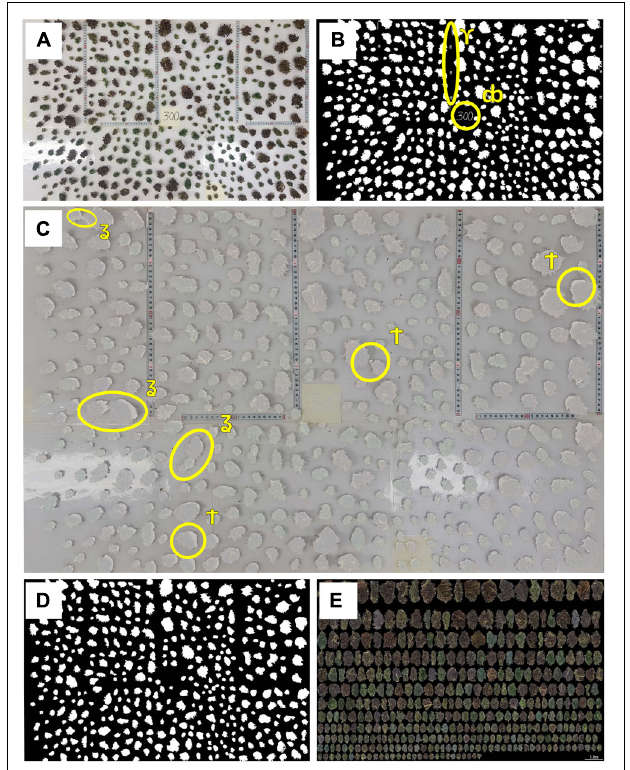
FIGURE 2 | Preparation procedure for inflorescence image analysis. (A) An example of the total processed inflorescences distributed over a scaled surface which formed the raw image for morphological analysis, (B) Binary (black and white) image of the distributed inflorescences, (C) Raw and binary images juxtaposed onto one figure to highlight any requirements for manual editing, (D) Processed (cleaned) binary image with only inflorescence material included, (E) Composite image containing all inflorescences within the examined plant which are ordered by size. The following symbols indicate areas of concerns in the raw data: Υ denotes a section with non-inflorescence material which needs to be removed;db indicates the location of plant index; ÿ shows areas of inflorescences contact which need to be separated and † indicates shaded areas to be removed which could be mistaken for inflorescence.